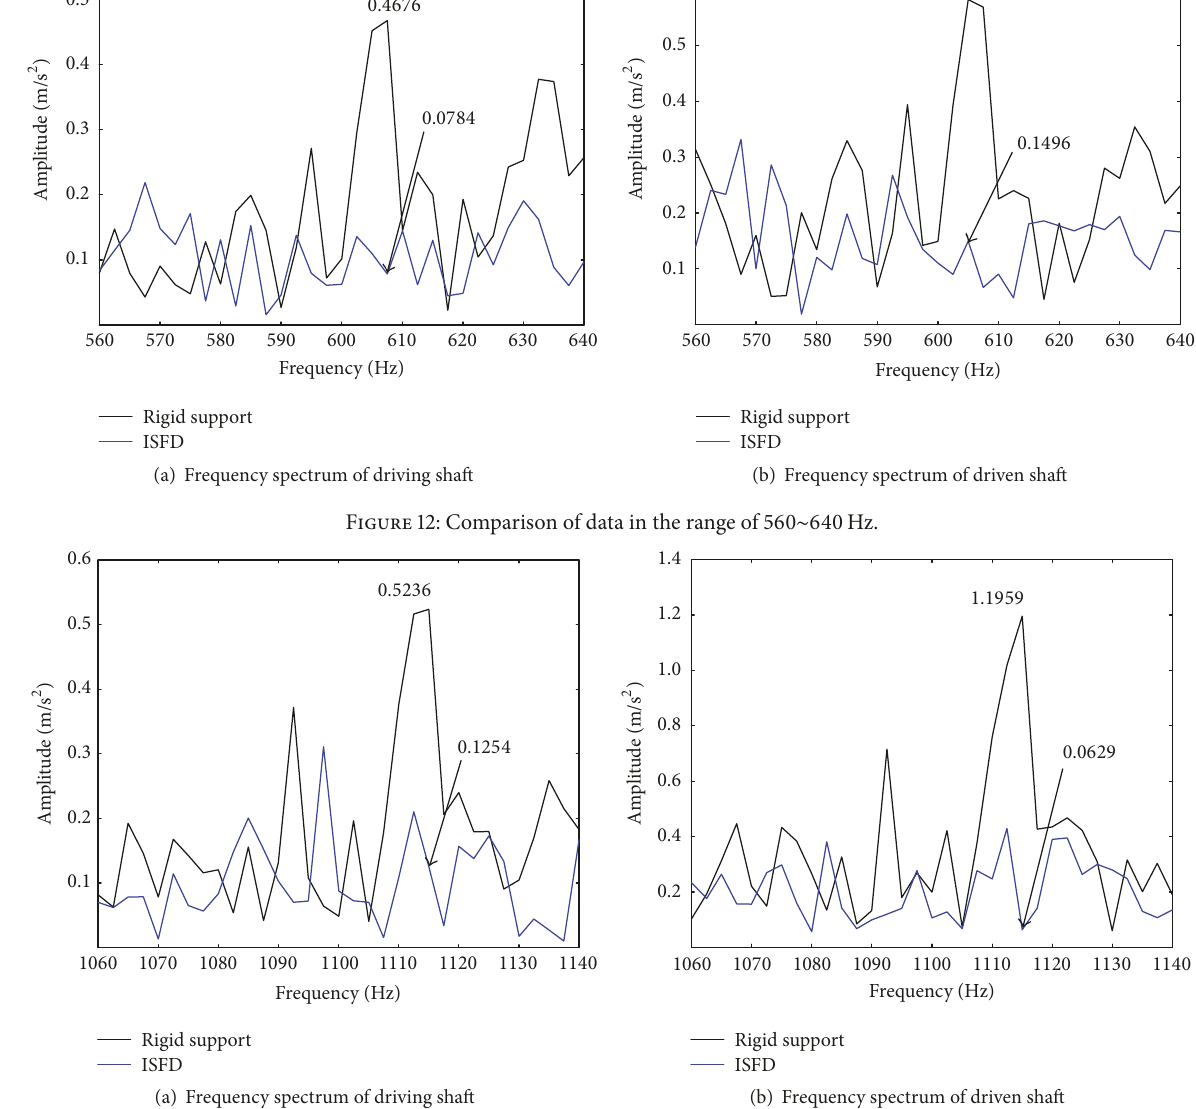
Figure 13: Comparison of data in the range of 1060 ∼ 1140Hz.